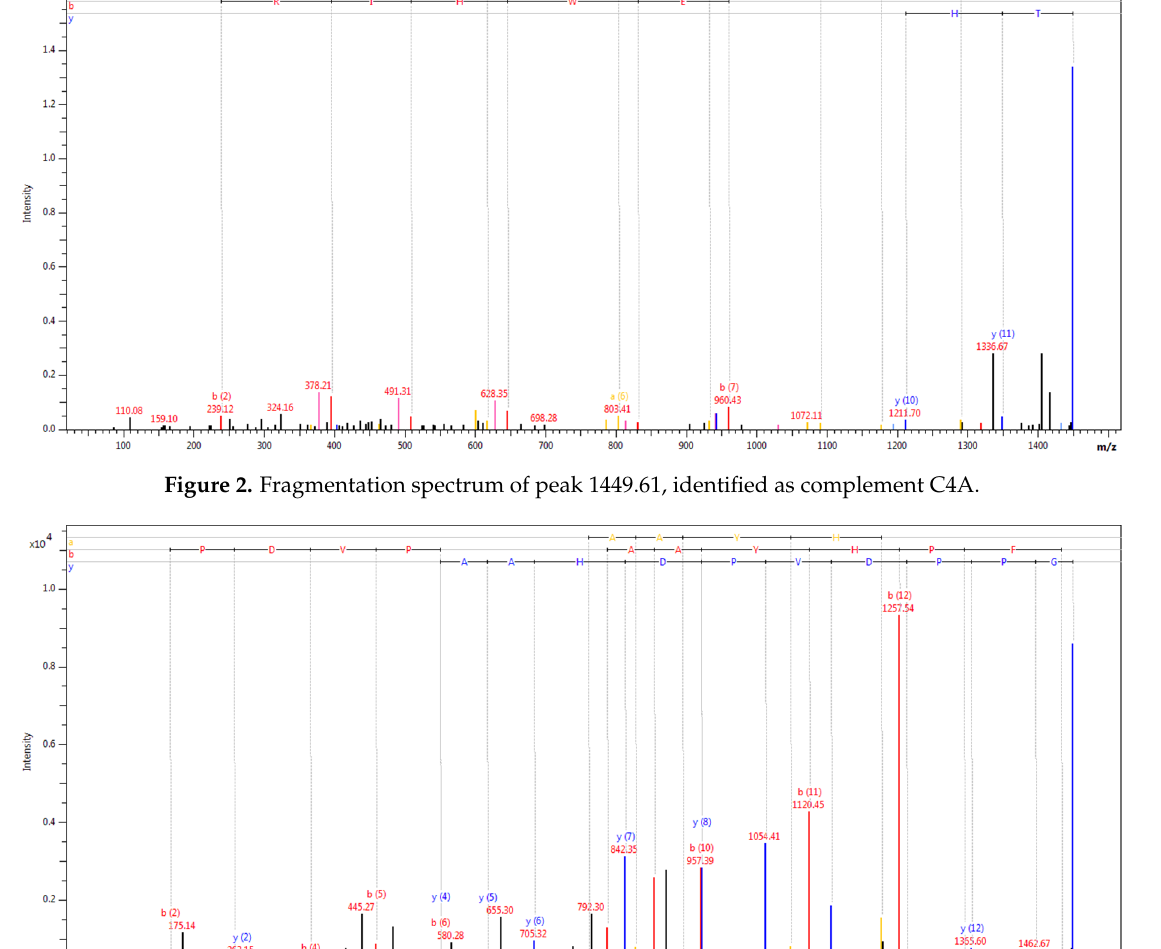
Figure 1. Fragmentation spectrum of peak 1617.79, identified as fibrinogen alpha chain.